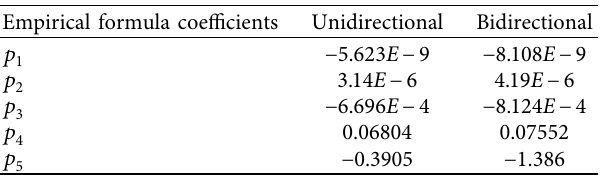
Table 7: Empirical formula coefficients of P − Φ characteristic curves.